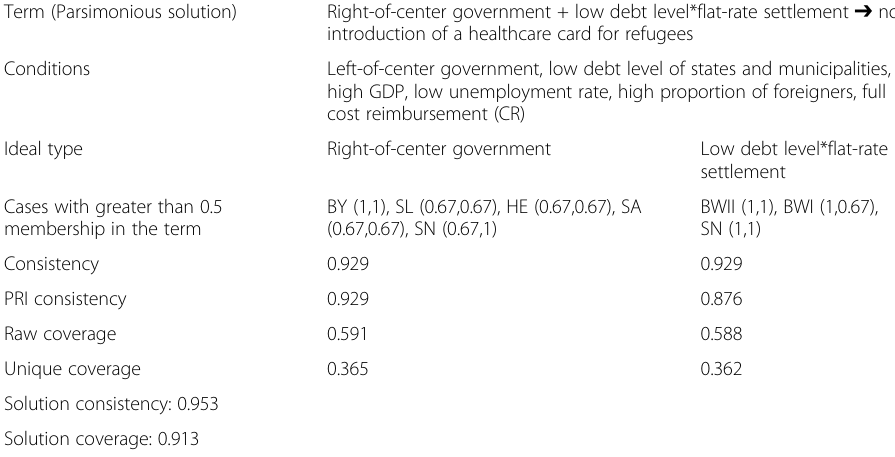
Table 4 Test for the sufficient conditions for the “ non-commissioning of health insurance providers ” outcome